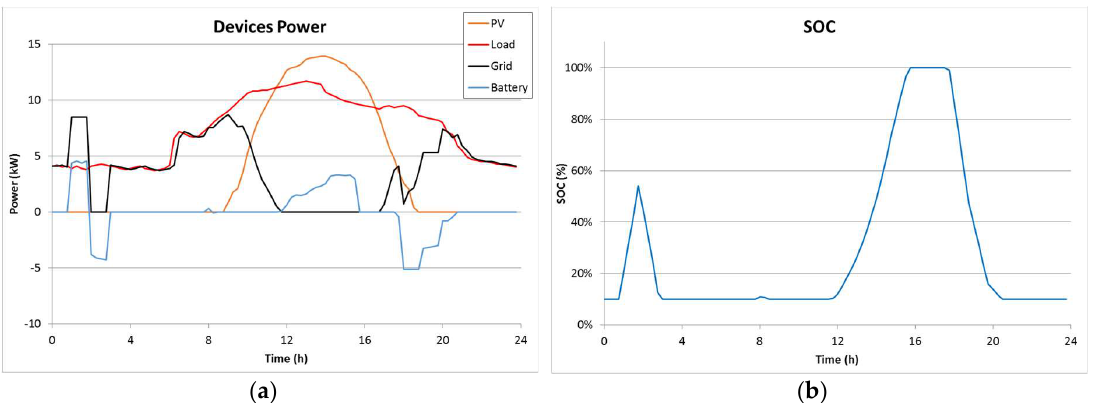
Figure 10. Simulations results for the state-of-the-art method: ( a ) Devices power; ( b ) Battery SOC.